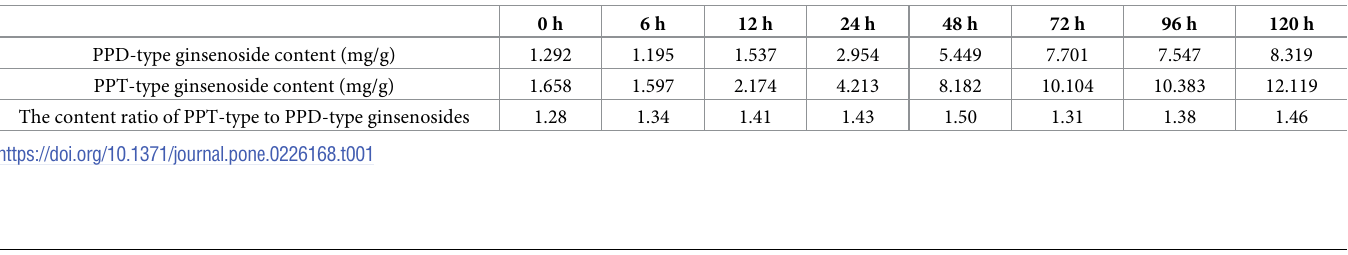
Table 1. The content ratio of PPT-type ginsenosides to PPD-type ginsenosides at different time points in MeJA-treated ginseng hairy roots.